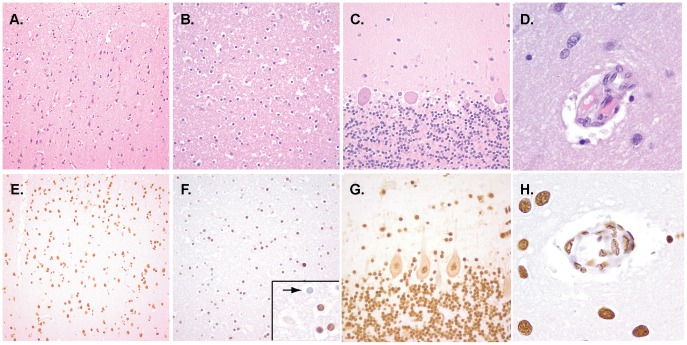
The adult human brain contains relatively high levels of 5hmC.Sections from multiple regions in the pediatric and adult human brain were stained for hematoxylin and eosin (A-D) and by immunohistochemistry for 5hmC (E–F). Both the pediatric and adult brain showed relatively strong staining for 5hmC in grey matter of the cerebral cortex (E), white matter (F), and granule and purkinje cell neurons of the cerebellum (G). The white matter showed some variability, with many 5hmC positive cells admixed with immunonegative cells (see inset of panel F, arrow). Additionally, stromal elements such as the cerebral vasculature (H) also showed relatively high levels of staining. The original magnification for D,H, and the inset of panel F is 400x. Original magnification for all other photomicrographs is 200x.